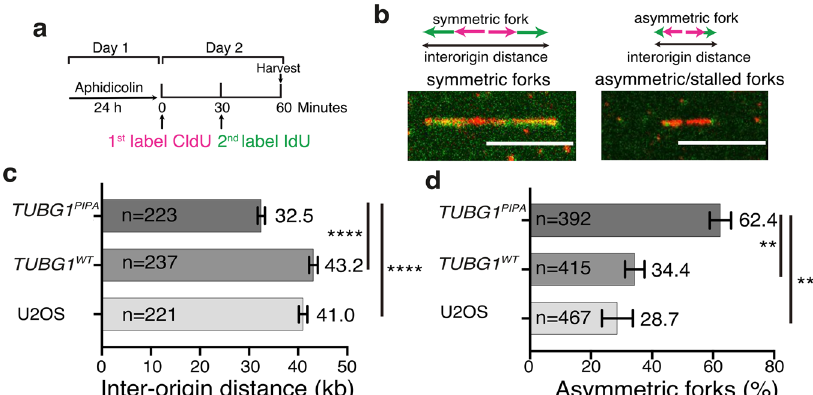
Fig. 9 A decreased replication fork progression in U2OSsg TUBG1 - TUBG1 A429-A432-A435 cells. a U2OS, TUBG1 -sgRNA-U2OS-TUBG1 (TUBG1 WT ), and TUBG1 -sgRNA-U2OS-TUBG1 A429-A432-A435 (TUBG1 PIPA ) cells were treated with aphidicolin for 24 h, followed by pulse labeling with chloro deoxyuridine (CldU) for 30 min and sequentially with iodo-deoxyuridine (IdU) for 30 min. b – d The confocal images show DNA fi bers containing stained symmetric and asymmetric forks and interorigin distance. Scale bars: 10 μ m. The graphs show the interorigin distance (initiation rate) and the percentage of asymmetric forks (stalled forks) in the indicated cell line (mean ± SD; **** P < 0.0001, ** P